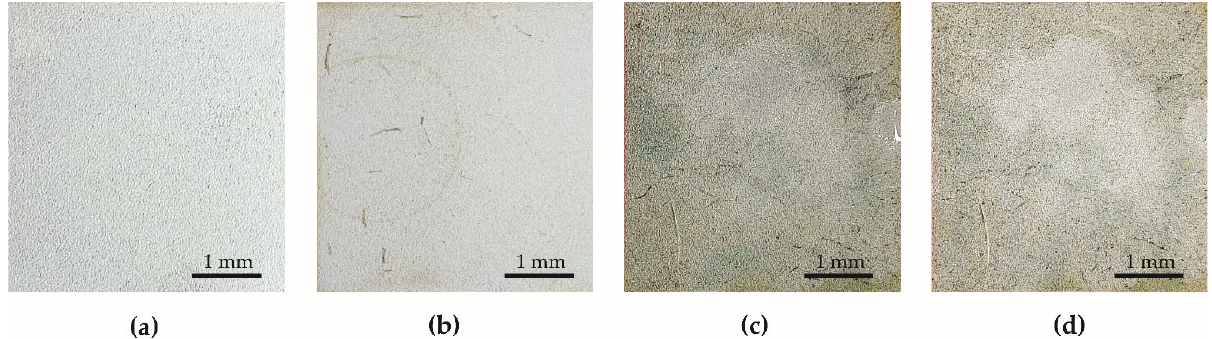
Figure 11. The specimen from Series 2 during the test in the pond: ( a ) before the test, ( b ) after 14 days, ( c ) after 112 days, ( d ) after 126 days (end of test).